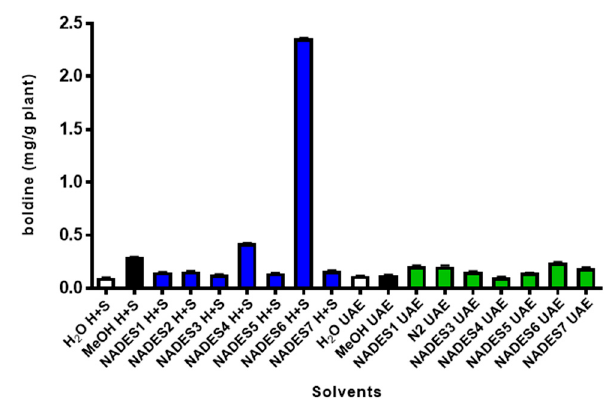
Figure 6. Effect of different NADESs on the extraction of boldine from Peumus boldus leaves with using heat + stirring (H + S, blue bars) and ultrasonic assisted extraction (UAE, green bars). In all extraction performed with NADES 1-7, 20% water was added to reduce viscosity. White and black bars corresponds to extraction performed with water and methanol, respectively.